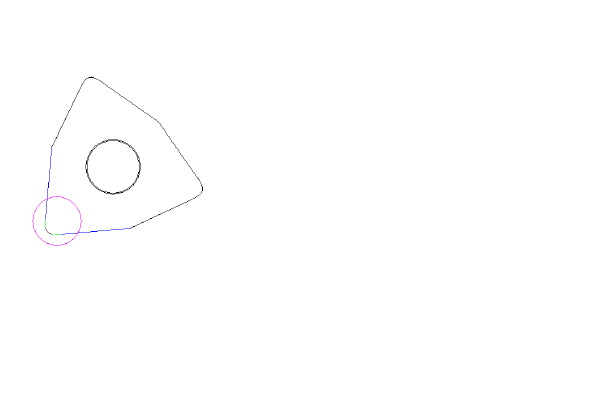
Figure 1. Shape of special insert prepared base on dimensions of ISO type of WNMG 080408 insert.